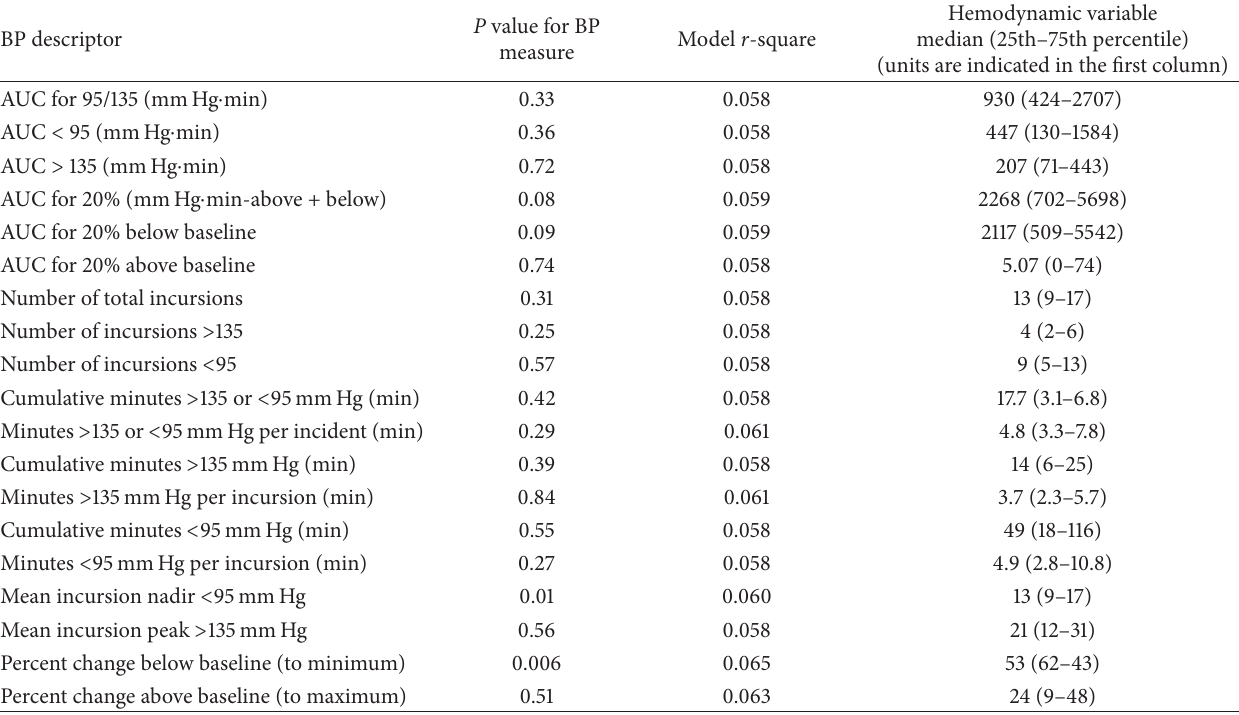
Table 2: Characterizations of blood pressure variability and association with percent delta creatinine .